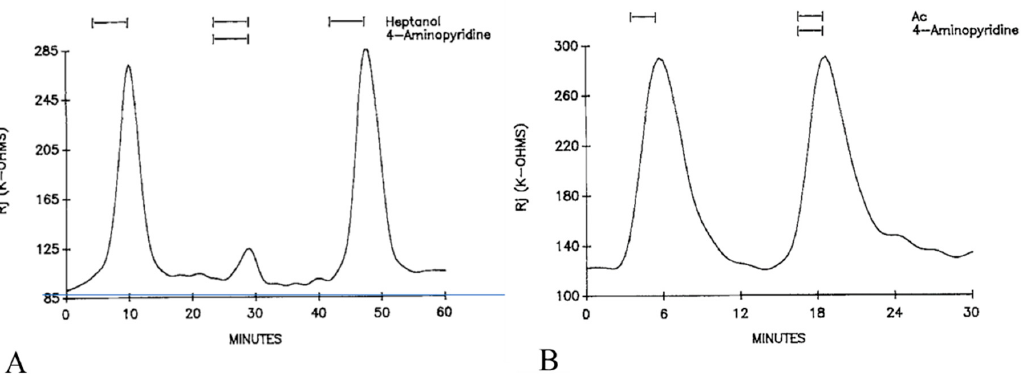
Figure 8. Time course of Rj in crayfish axons uncoupled by heptanol ( A ) or acetate ( B ) in the presence or absence of 5 mM 4-aminopyridine (4-AP). 4-AP dramatically reduce the Rj maximum with heptanol ( A ). In contrast, addition of 4-AP to acetate solutions (Ac) does not affect the acetate-uncoupling efficiency ( B ). Adapted from [16].